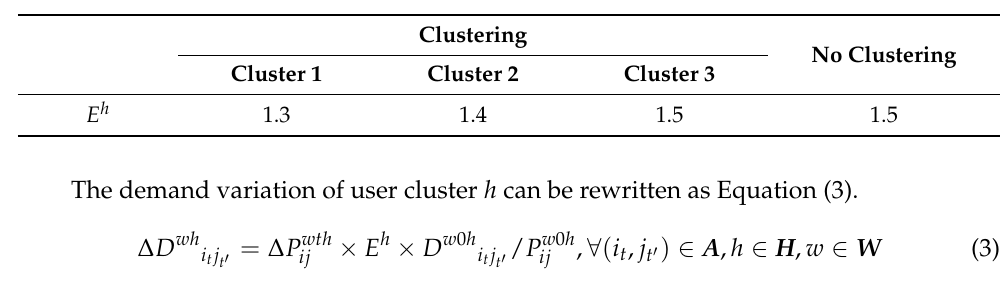
Table 2. Price elasticity for each user cluster.